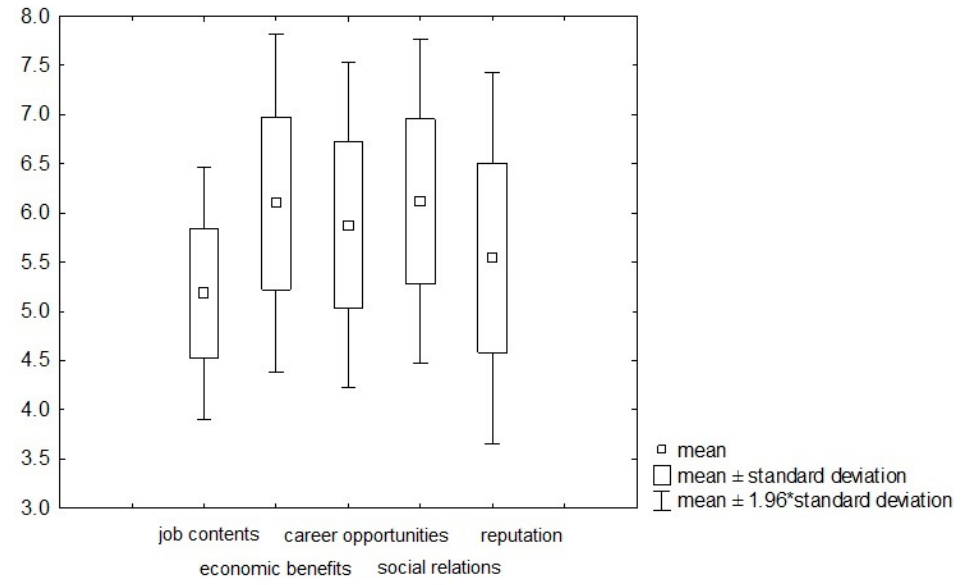
Figure 2. The respondents’ expectations concerning an ideal workplace. Source: own research.